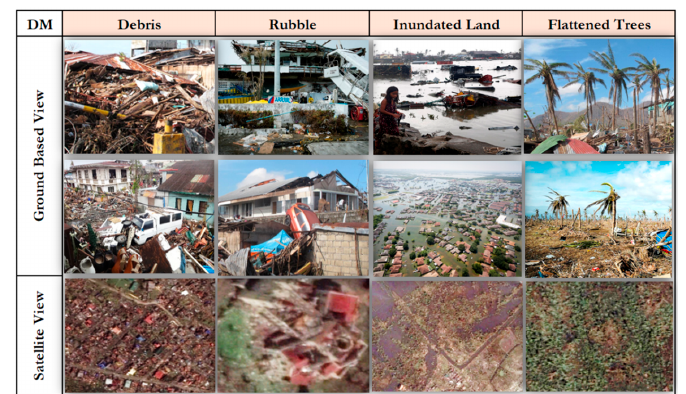
Figure 7. Illustration of damage classes, both ground and satellite views; DM: Damage class, sources: Satellite view from World-View2 and Google Earth; ground-based view from Google Street View, Flicker, Wikipedia, Wikimedia.